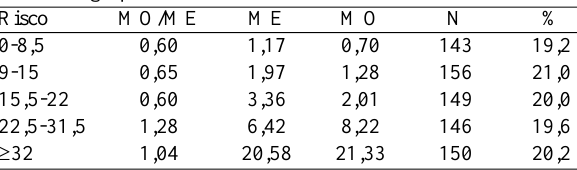
Tabela 3. Porcentagens da mortalidade observada e estimada